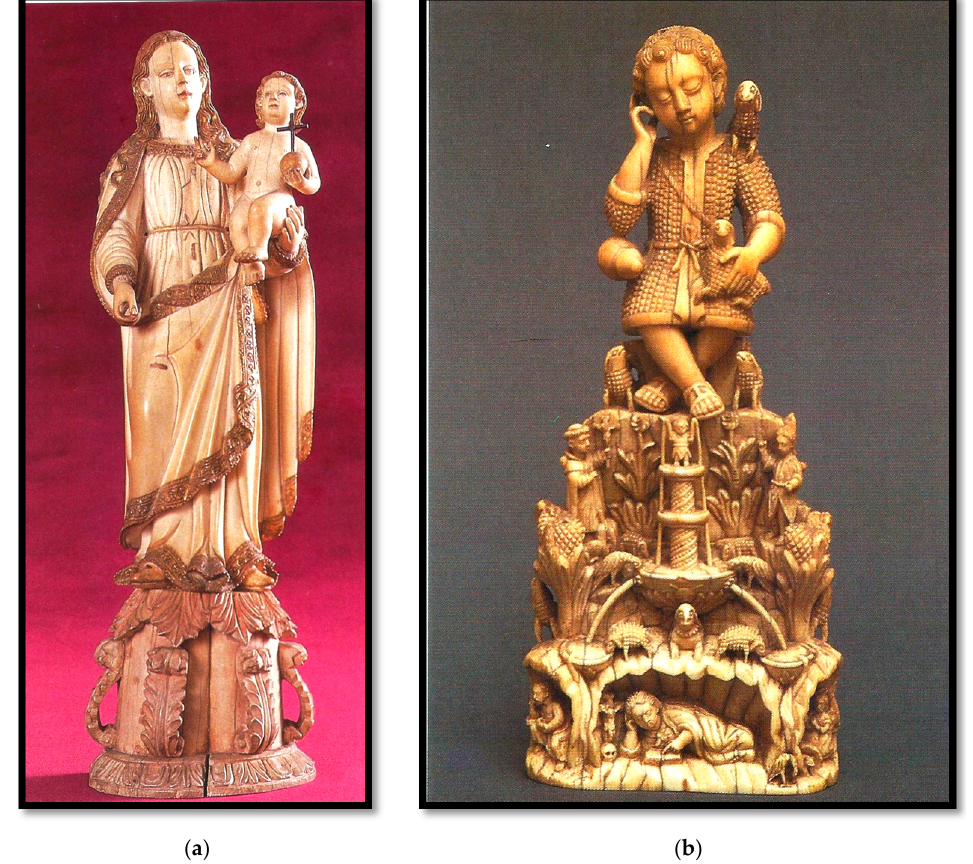
Figure 2. Indo-Portuguese Ivories from Goa; ( a ) Madonna and Baby Christ, 17th century, 300 mm., Antonio Costa Collection, Lisbon; ( b ) Christ Child as the Bom Pastor, 17th century, 230 mm., Heirs of Bernardo Ferr ā o, Oporto.